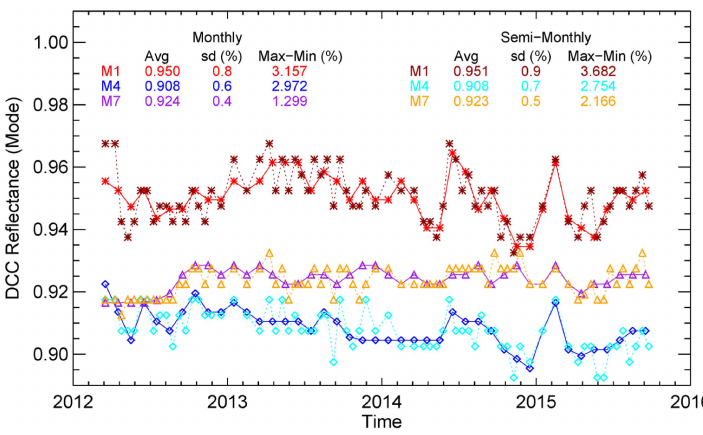
Figure 6. Comparison of monthly and semi-monthly DCC mode time series for M1, M4, and